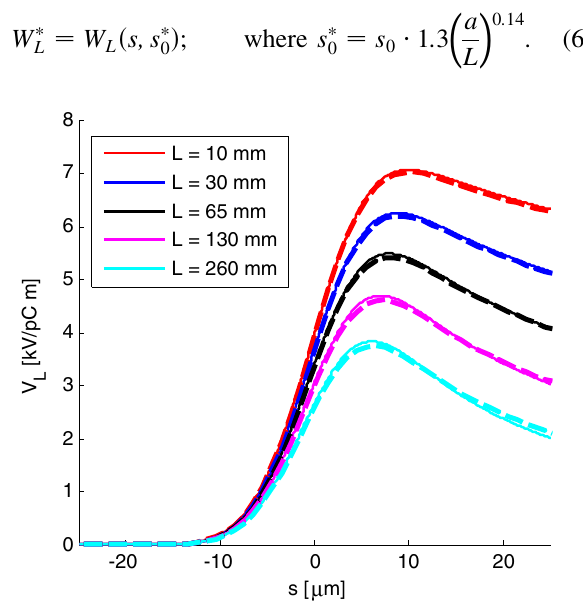
FIG. 4. Short-range longitudinal wake potentials for a bunch of ¼ 5 (cid:2) m were calculated using the KB* model (solid lines) (cid:1) z and the ECHO2D code (dashed lines) in the periodic structure of radius a ¼ 2 mm for different values of L (see color code in the